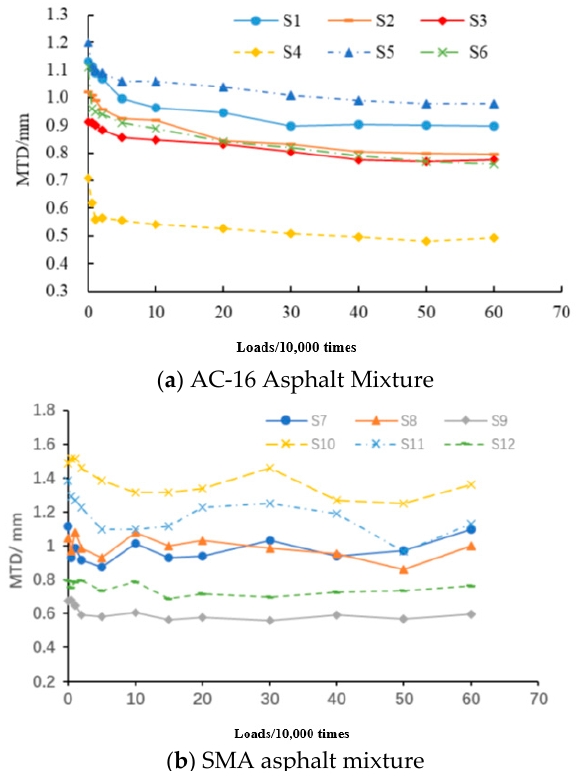
Figure 5. The relationship between MTD and accelerated loading times.